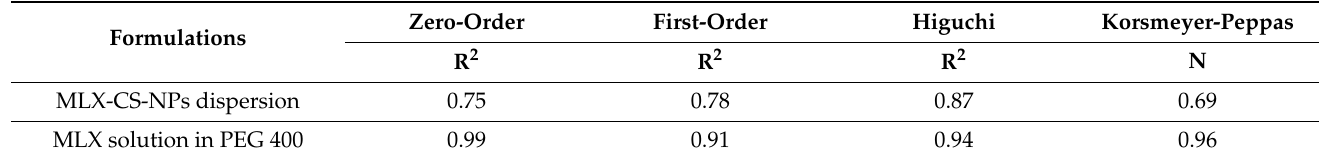
Table 7. Kinetic analysis of the in vitro release data of MLX from MLX-CS-NPs dispersion and MLX solution in PEG